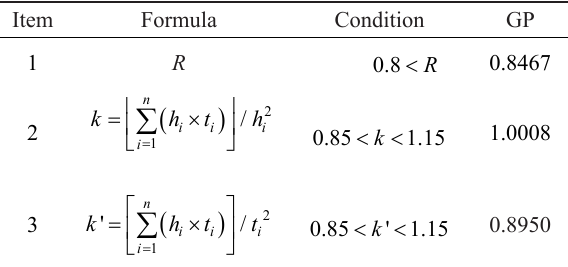
Table 2. Statistical parameters of the GP model for the external validation Item